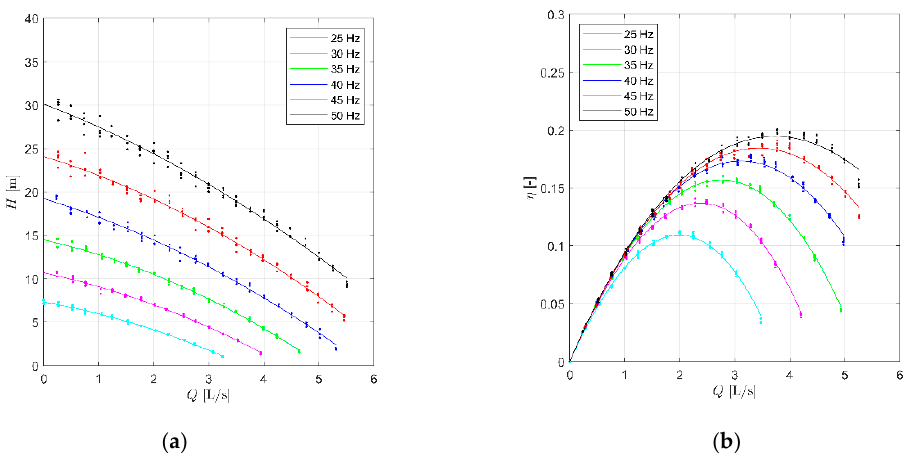
Figure 7. Characteristic ( a ) and efficiency ( b ) curves of a pump affected by hard wear.